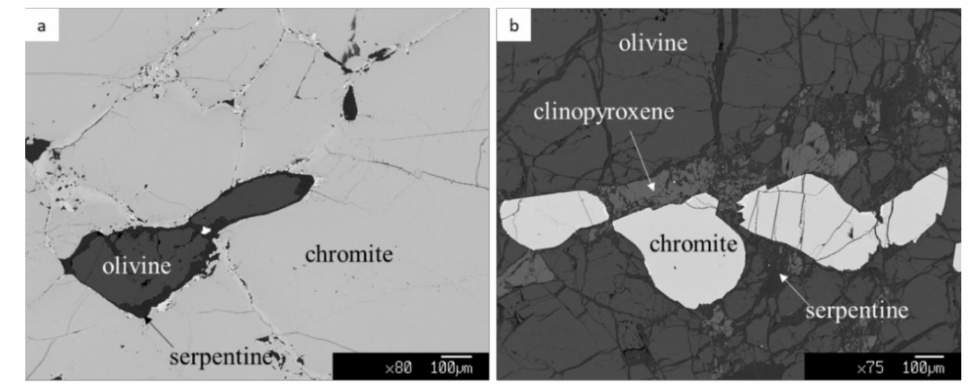
Figure 6. BSE images of Iballe ( a ) massive chromitite; ( b ) fresh dunite.